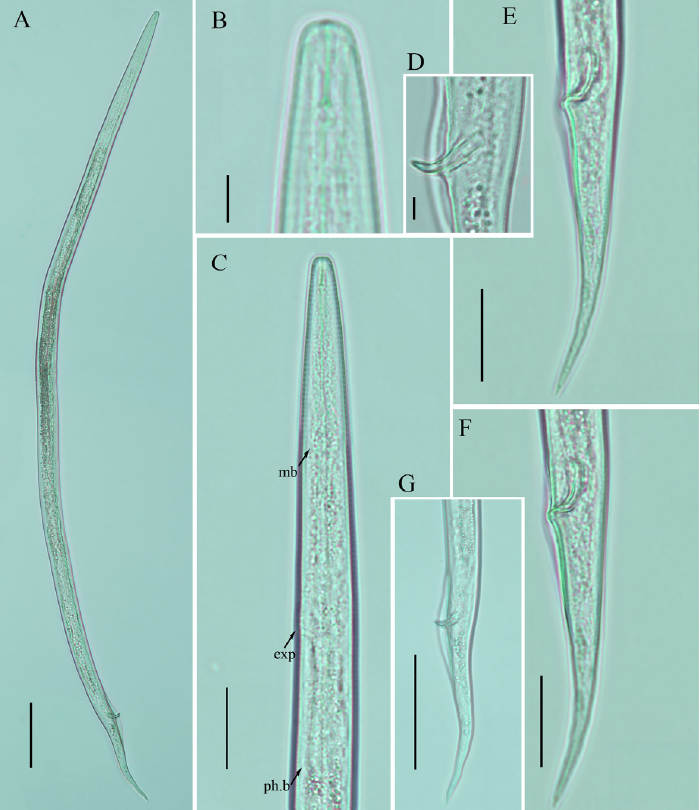
Figure 7. Photomicrographs of male Ditylenchus valveus Thorne and Malek [31] ( A ) Entire body; ( B ) lip region; ( C ) pharyngeal region; ( D ) spicule; ( E – G ) tail regions. Scale bars: ( A , G ) 50 µm; ( C , E , F ) 20 µm; ( D ) 5 µm. Arrows: (exp) secretory–excretory pore; (mb) median bulb; (ph.b) pharyngeal bulb.